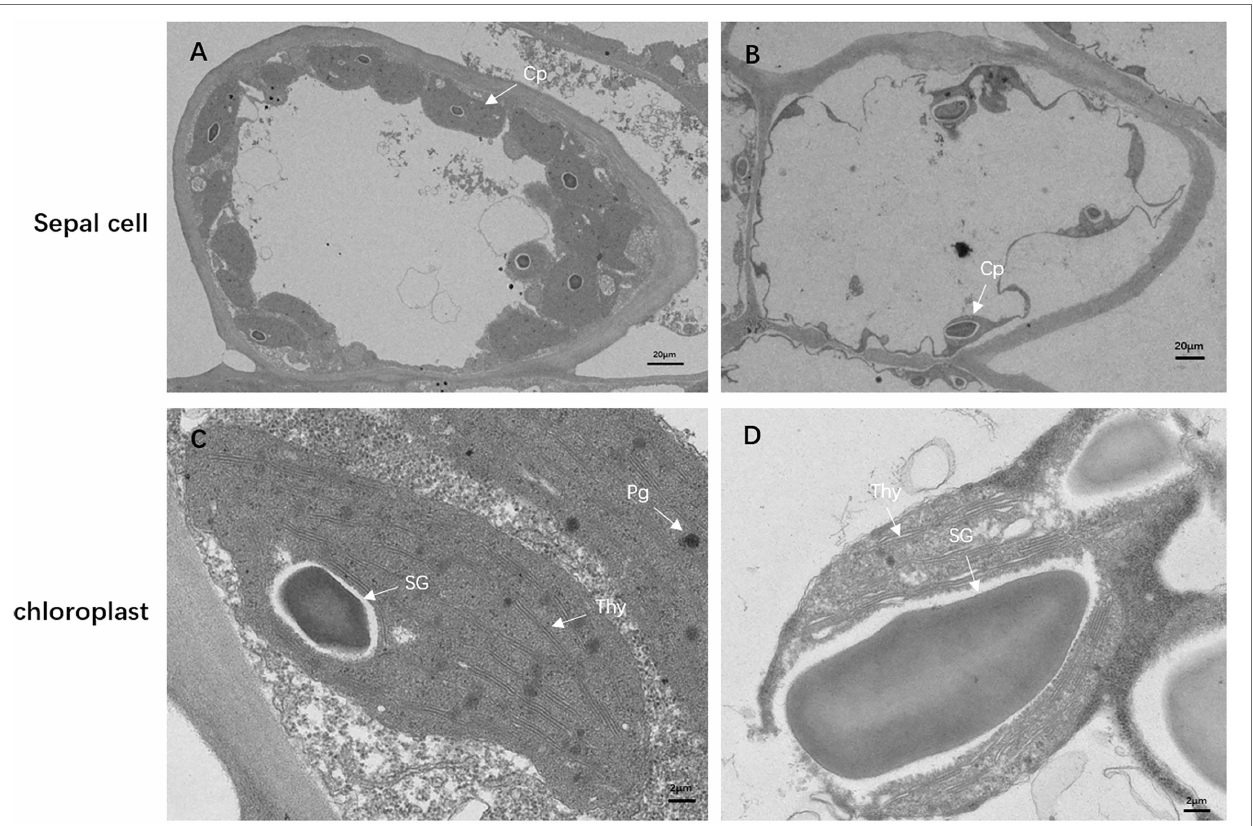
FIGURE 3 | Transmission electron micrographs of chloroplasts from NY18 (A,C) and df74 (B,D) . Examples of chloroplast (Cp), plastoglobule (Pg), starch granules (SG), and thylakoid (Thy). Bars: 20 μ m (A,B) , 2 μ m (C,D)